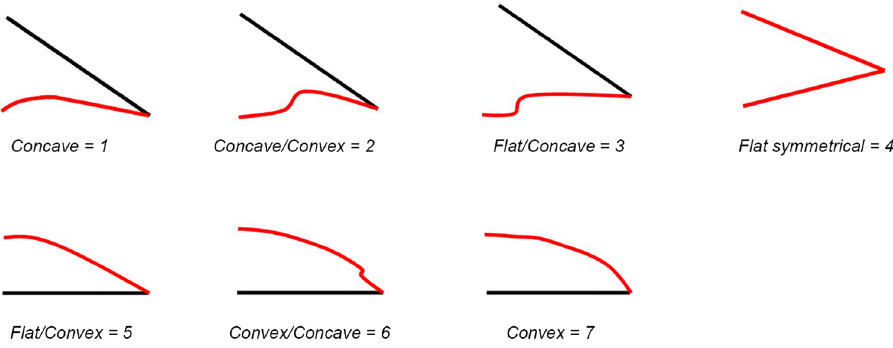
Fig 4. Classes of cutting edge bevel in cross-section